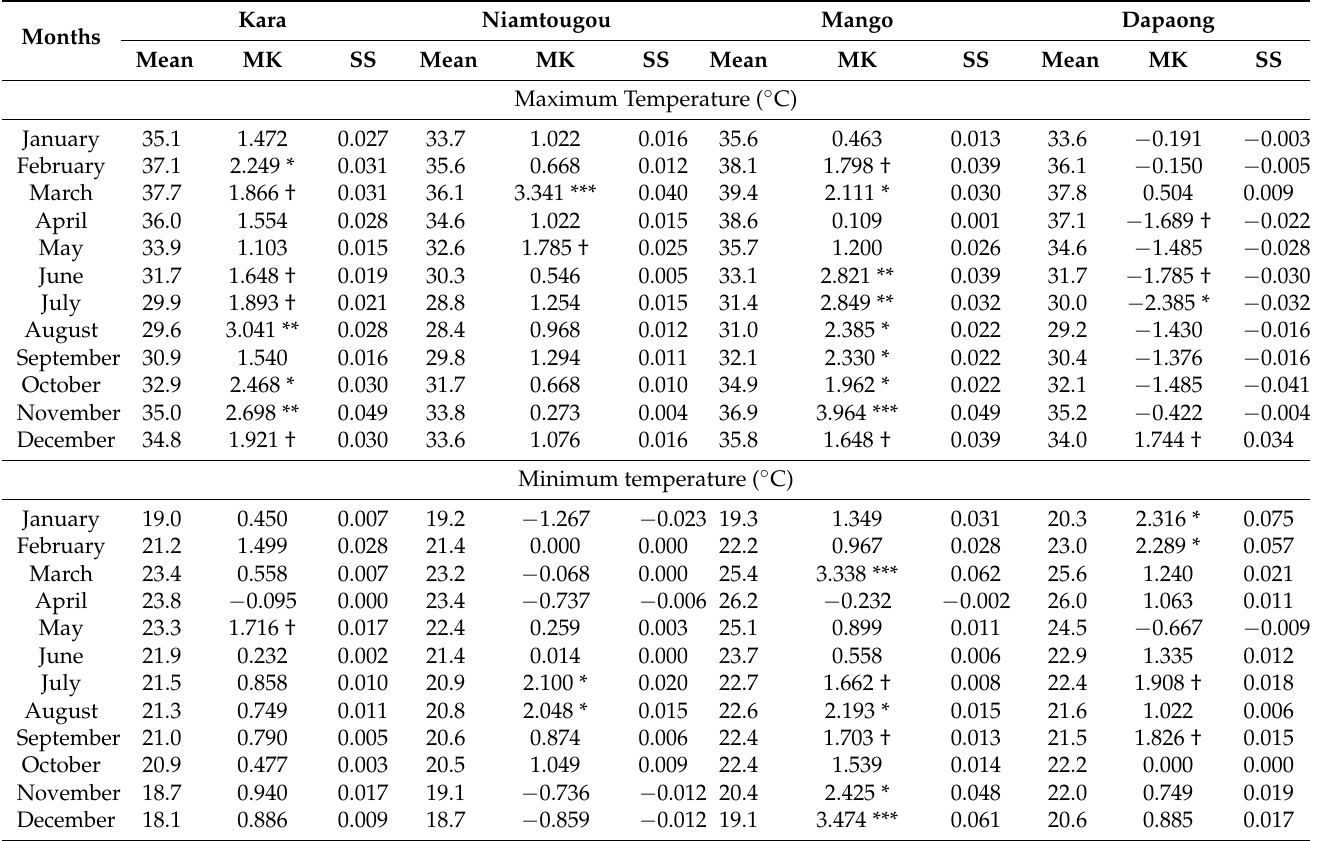
Table 7. Summary of the modified Mann–Kendall (MK) test and Sen’s Slope test (SS) (Trend-Free Pre-Whitening) of the monthly minimum and maximum temperature ( ◦ C) in Kara, Niamtougou, Mango and Dapaong. Kara Niamtougou Mango